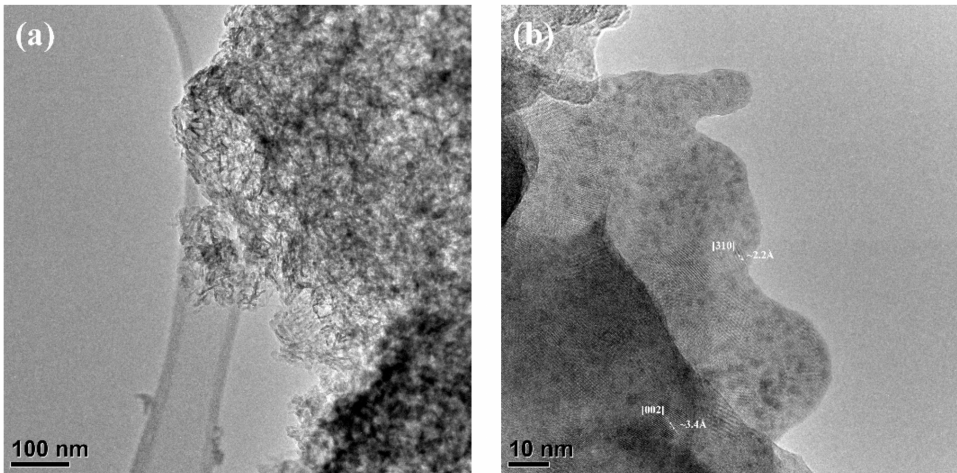
Figure 5. High-resolution TEM data of the Fe-HA7 ( a , b ) powders.